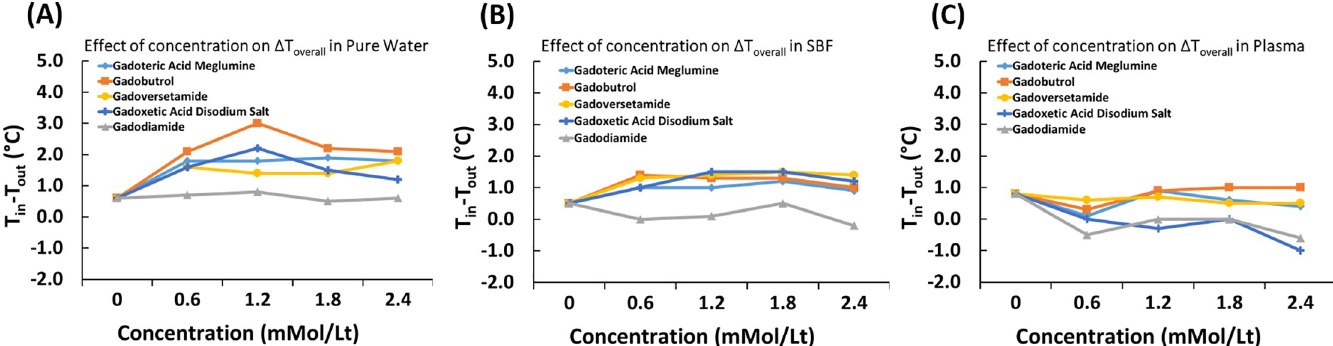
Fig 3. Effect of GBCA concentration and type on temperature change within the entire process in different dilution media. (A) pure water, (B) Simulated body fluid-SFB, (C) plasma. Concentrations: 0.6, 1.2, 1.8, 2.4 mMol/L.